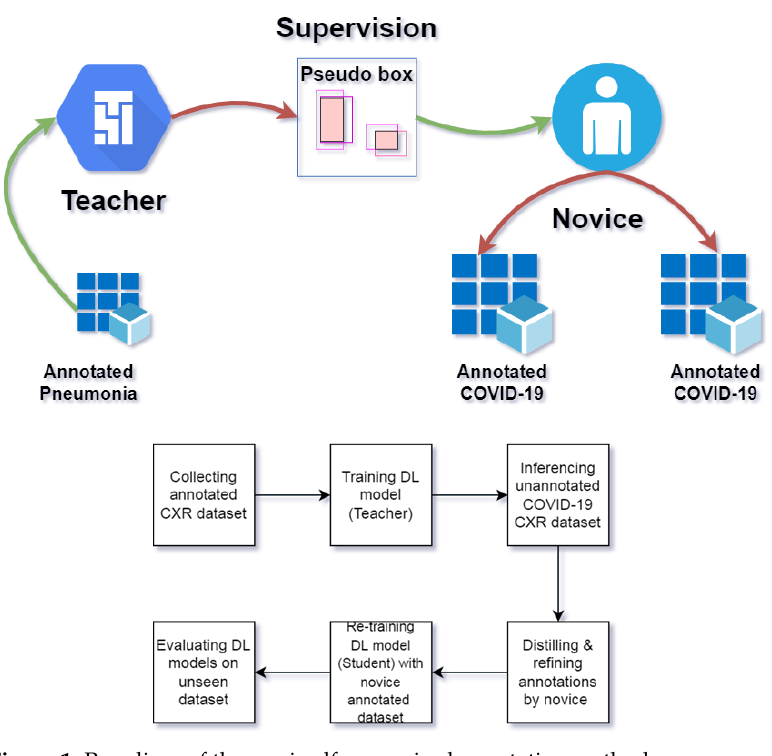
Figure 1. Paradigm of the semi-self-supervised annotating method.